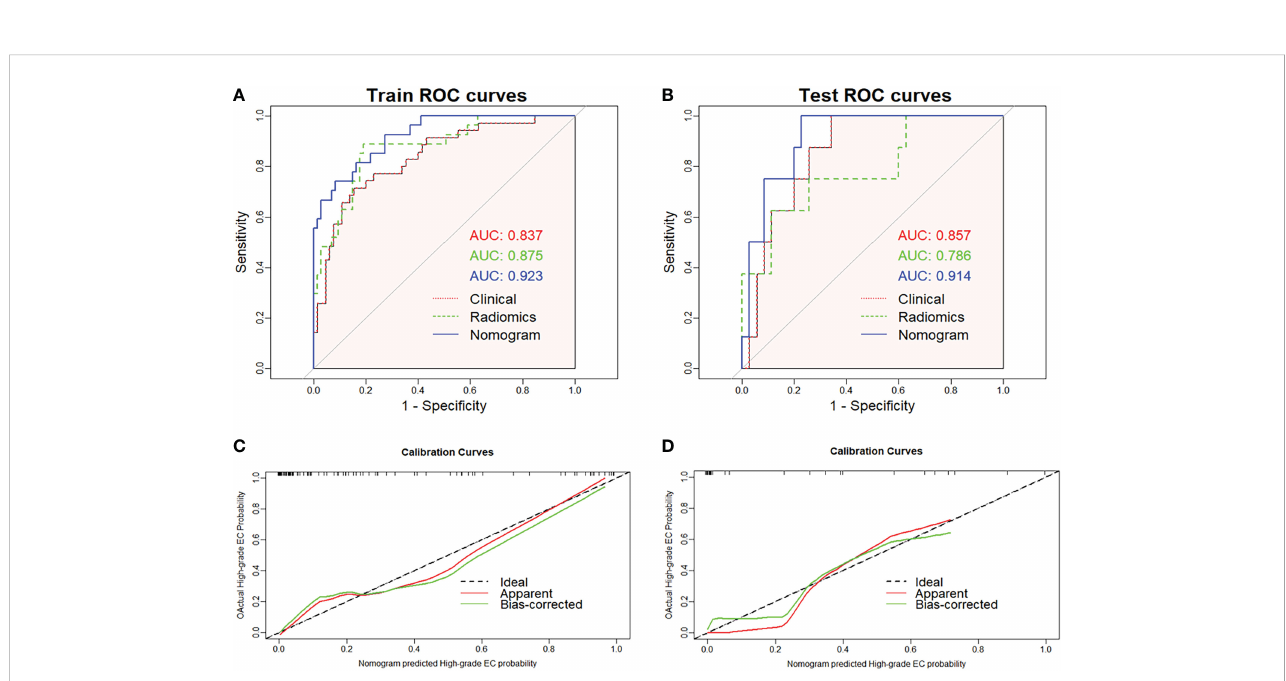
FIGURE 5 Receiver operating characteristic curves of the three models predicting high-grade endometrial cancer in the training (A) and validation sets (B) . The graphs (C) and (D) show that the calibration curve of nomogram has good calibration ability in both the training and validation sets,